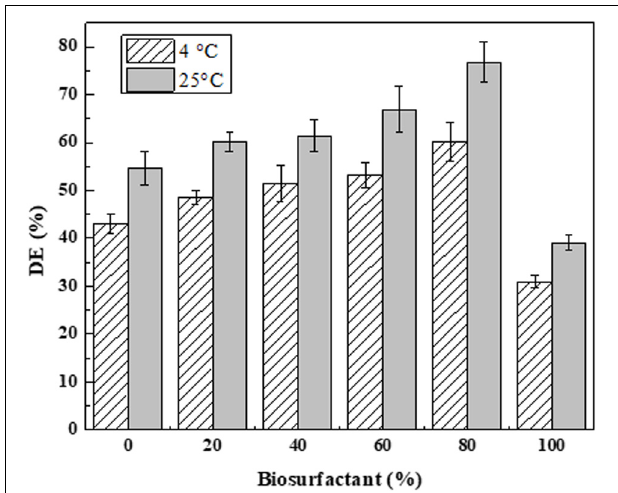
FIGURE 8 | Effectiveness of ANS oil dispersion (DE) by the newly developed dispersant. A series of co-surfactants was prepared by mixing biosurfactant solution (3.6 g L - 1 ), and DOSS at a ratio of 0:10; 2:8; 4:6; 6:4; 8:2; and 10:0 (v/v). Each biodispersant was composed of one co-surfactant and PEG 400 at a ratio of 3:7 (v/v). The effectiveness of biodispersant was determined at a dispersant to oil ratio (DOR) of 1:25 (v/v) under 4 and 25 ◦ C following the baffled flask